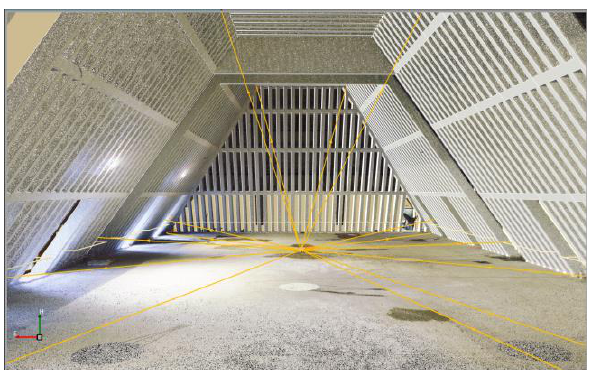
Figure 3 . BIM model and scan data referenced to TPS observations (yellow vectors), resected from GNSS control points.